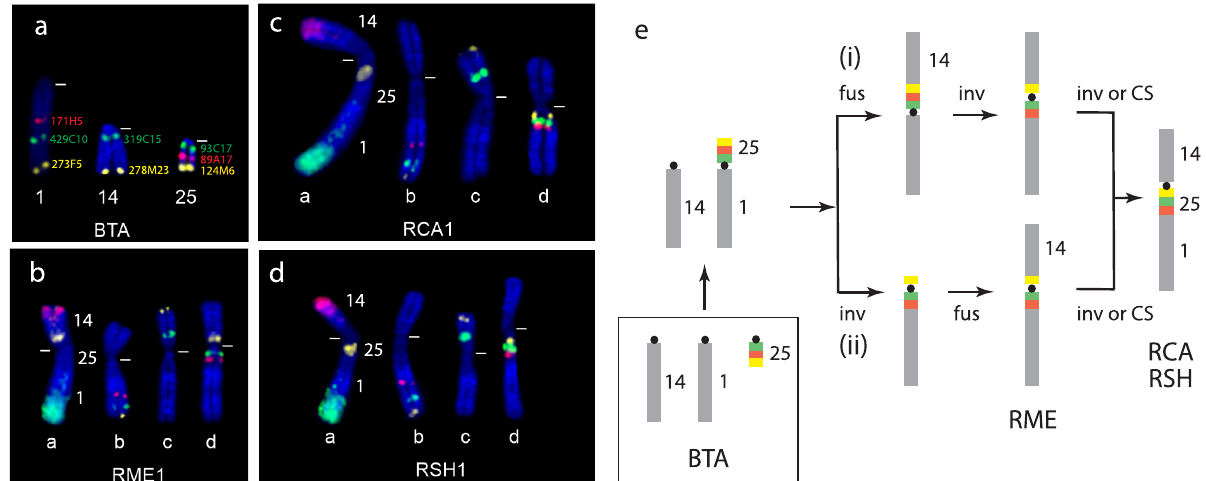
Figure 2. FISH analysis of Raphicerus chromosome 1. ( a – d ) Images showing the relative positions of eight BACs on BTA1, BTA14 and BTA25 that were used to orientate the corresponding orthologous segments in the Raphicerus species. The first chromosome in in panels b - d shows hybridization to the region-specific painting probes BTA1qd, BTA14qd and BTA25qd; grey bar indicates centromere position. ( e ) Schematic reconstruction from these data showing two possible derivations (i and ii) of this autosome (see text for details). Key: inv inversion, fus fusions, CS centromeric